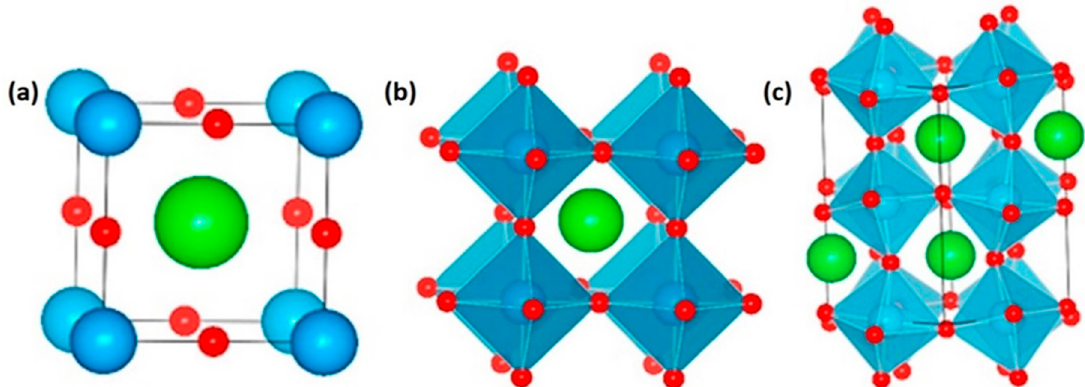
Figure 1. ( a ) The unit cell of cubic perovskite, where the blue spheres at lattice corners are A cations, the green sphere at the center is a B cation, and the red spheres at the lattice faces are X anions. ( b ) Another illustration of BX 6 octahedral network, where B cations are surrounded by X anions. ( c ) A tilted BX 6 octahedral structure due to non-ideal size effects and additional factors. Reprinted from [23], with permission from Elsevier.